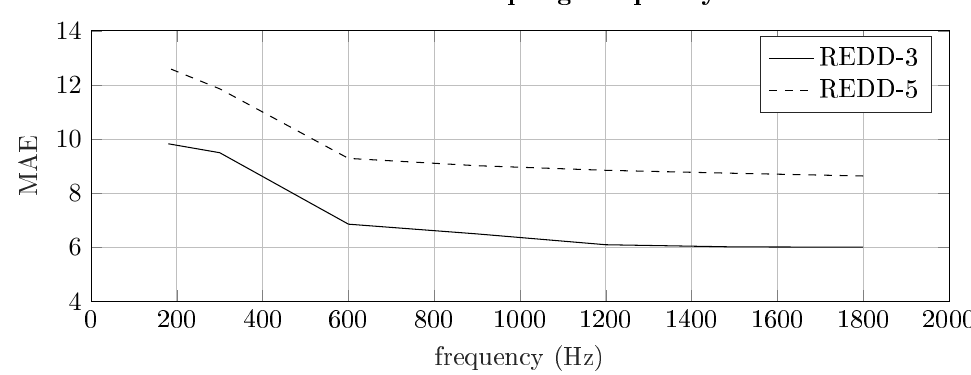
Figure 5. Performance for the REDD database for different sampling frequencies using PQ- transformed signals.